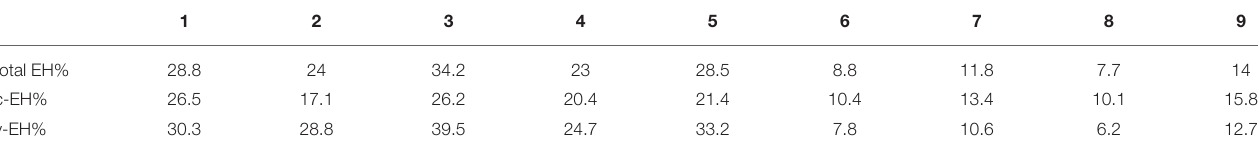
TABLE 1 | Sequential values of the volume ratio of endolymphatic hydrops (EH) in the right ear according to